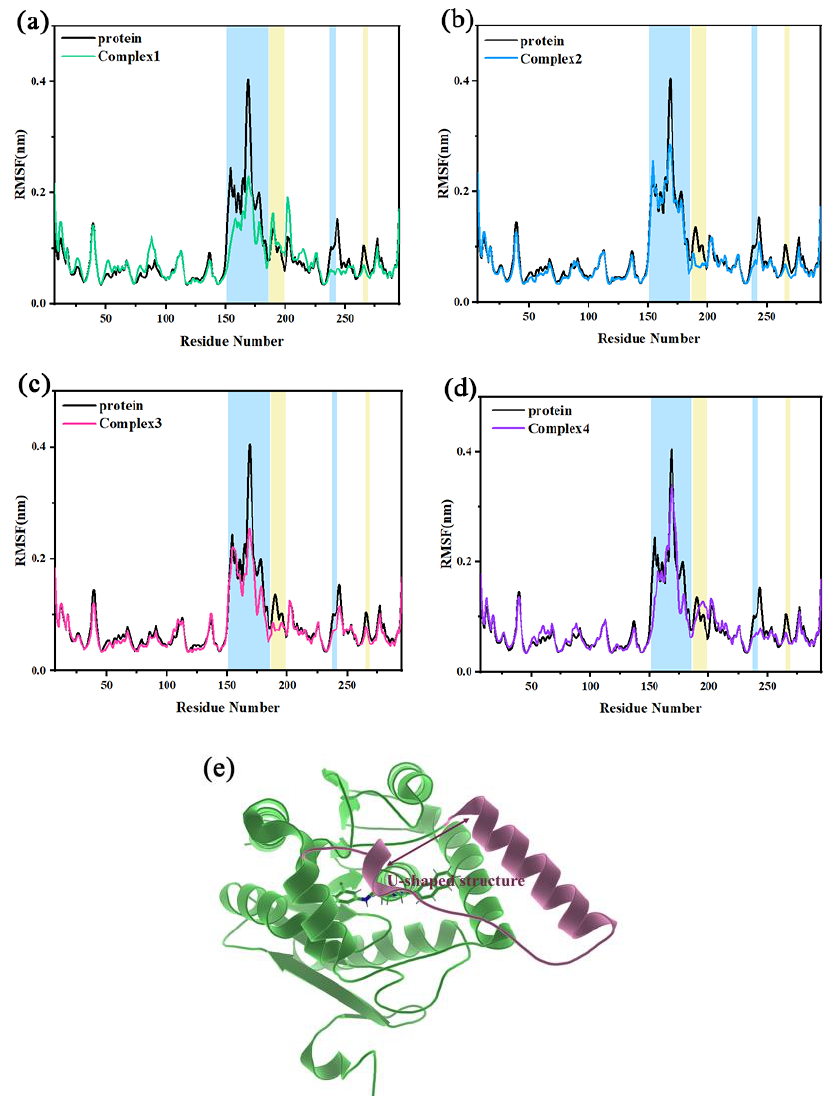
Figure 4. ( a – d ) The RMSF of independent protein and the four complexes are compared, with several areas of significant difference highlighted in blue and yellow backgrounds, respectively. ( e ) The position of the U-shaped structure in the protein.